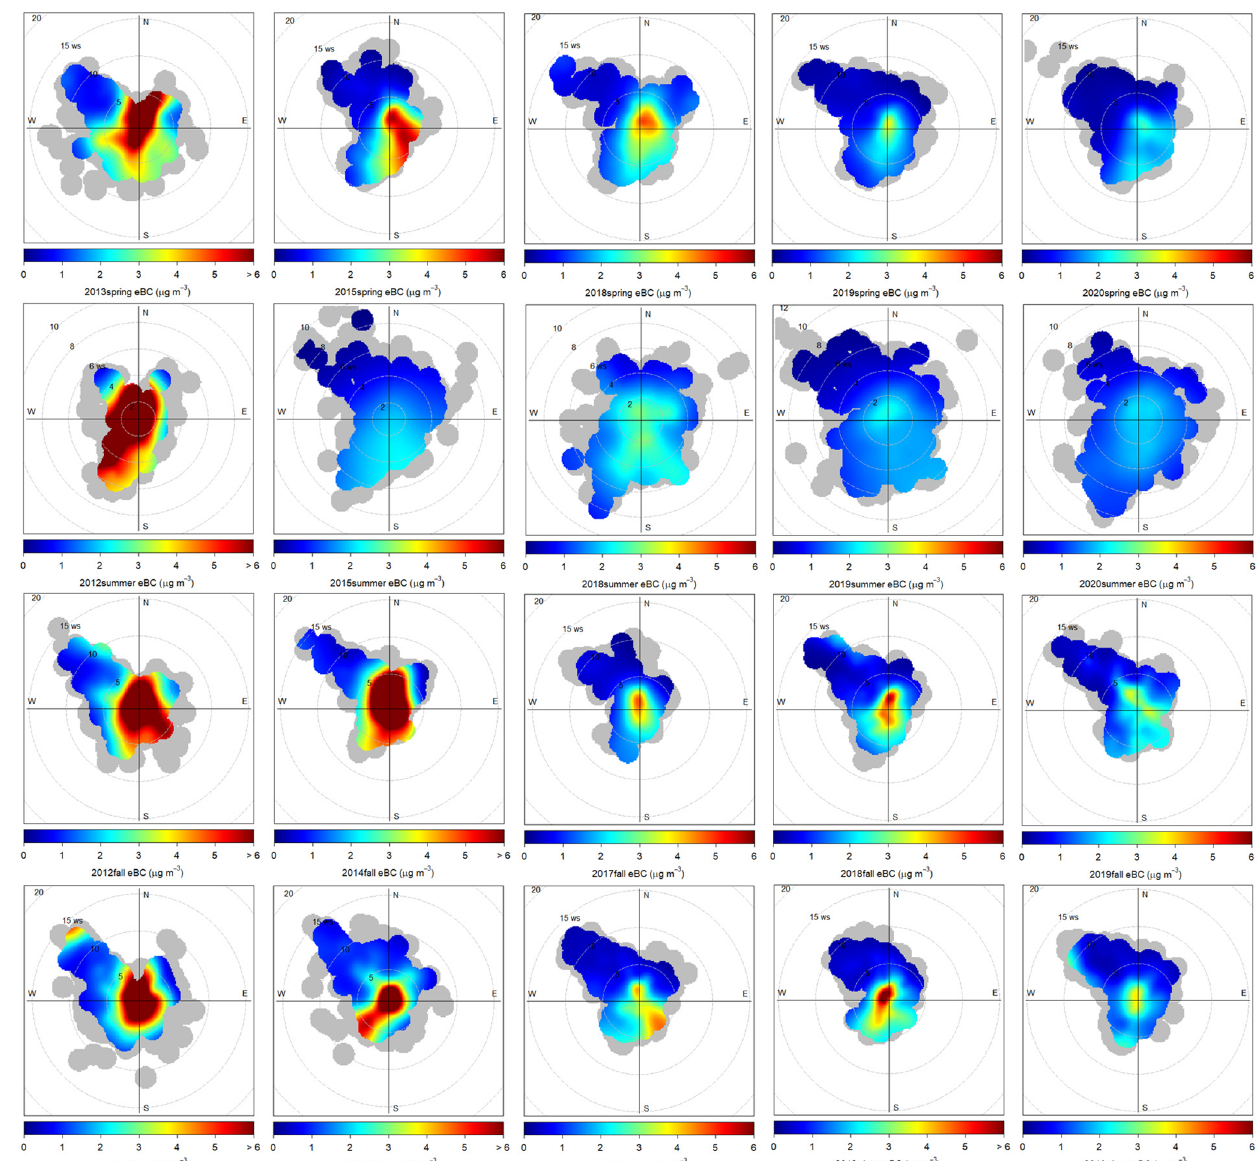
Figure 5. Bivariate polar plots for hourly eBC mass concentration in the four seasons over 9